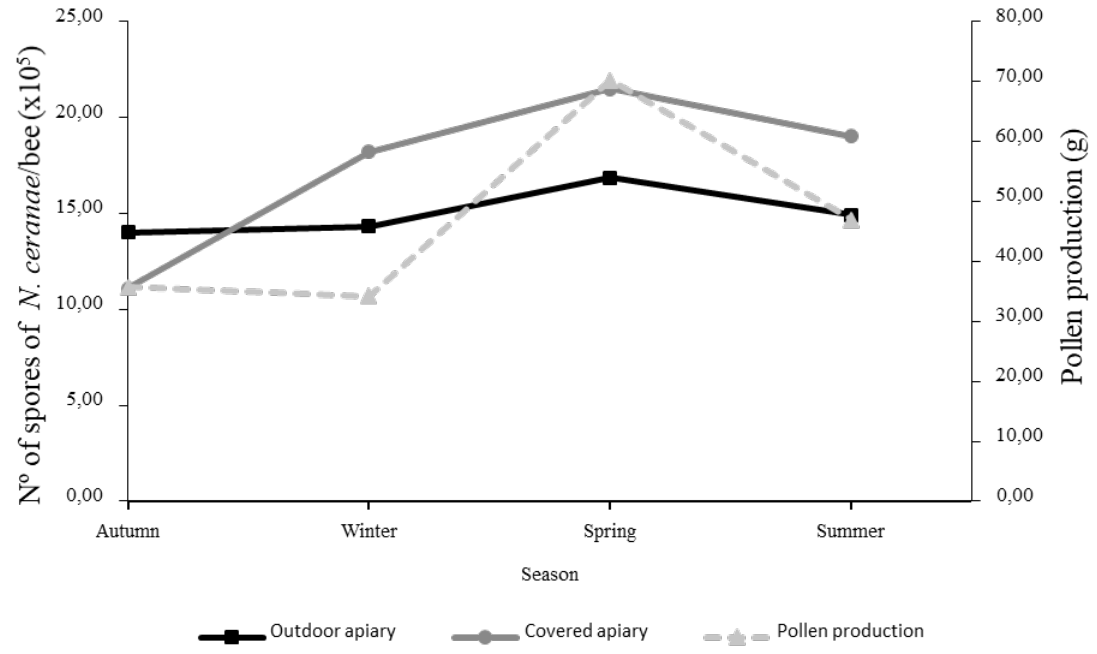
Fig 4 . Intensity of natural infection of Nosema ceranae (mean number of spores/bee x10 5 ) and precipitation in hives located in outdoor apiary and covered apiary from August 2013 to August 2016 in relation to the seasons.